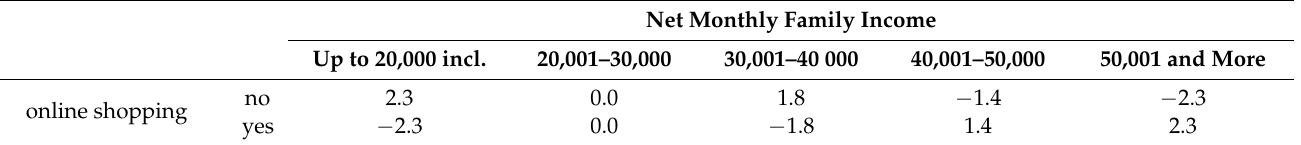
Table 6. Adjusted standardized residuals, cut-off value 2.807 (variables online organic food purchases and monthly family income), in